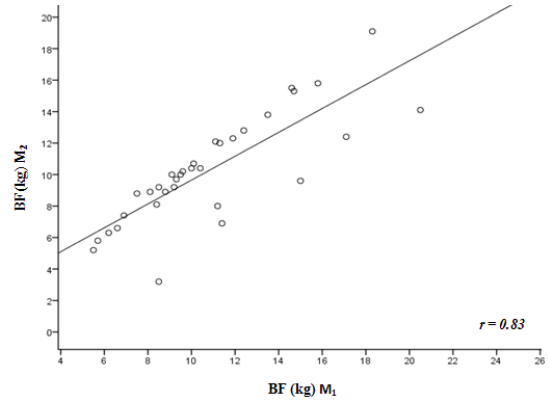
Figure 6. Correlation between the values of param- eters measured by Nutriguard-M before and after the intake of fluids – body fat (kg)